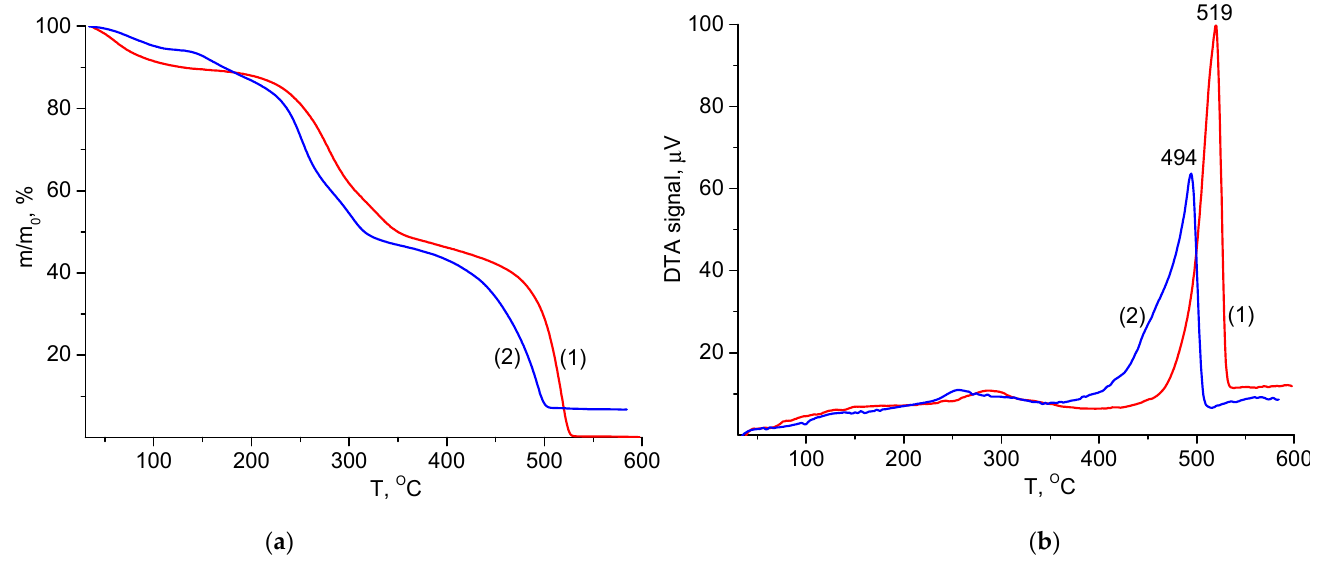
Figure 5 . TGA ( a ) and and differential thermal analysis (DTA) ( b ) curves of (1), CS(80)-BCd(20), (2), CS(80)- ВС d(20)-CeONP(8) films in air atmosphere.